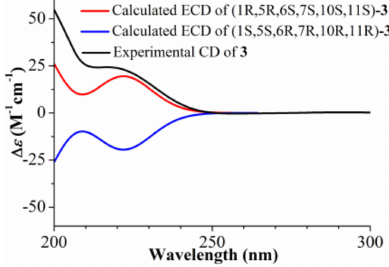
Figure 5. Calculated and experimental ECD spectra of compound 3